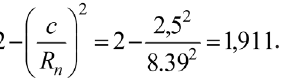
Figure 14: Comparison of the bending moment